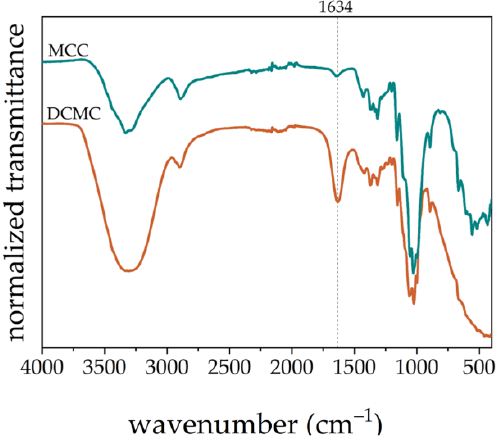
Figure 2. FTIR-ATR spectra of microcrystalline cellulose (MCC) and DCMC.